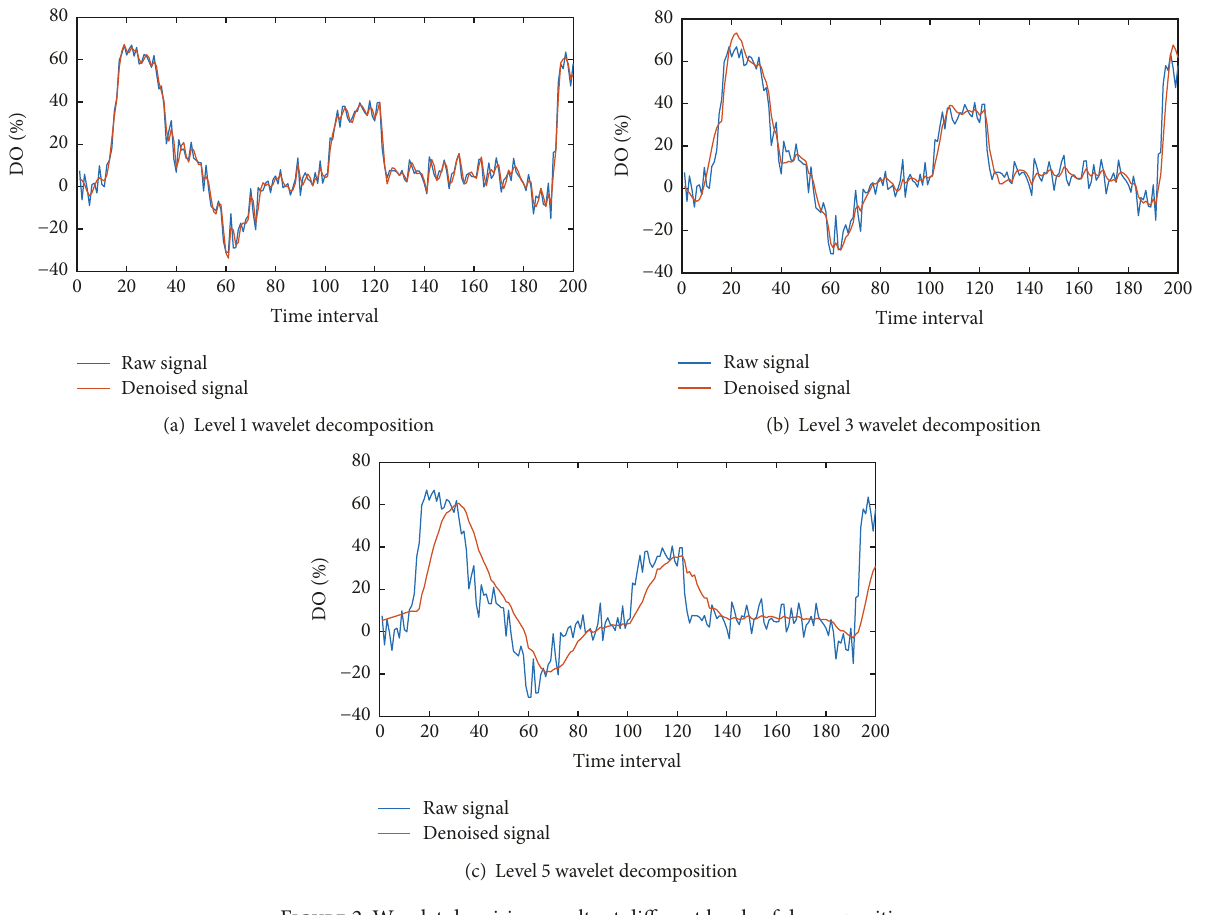
Figure 2: Wavelet denoising results at different levels of decomposition.